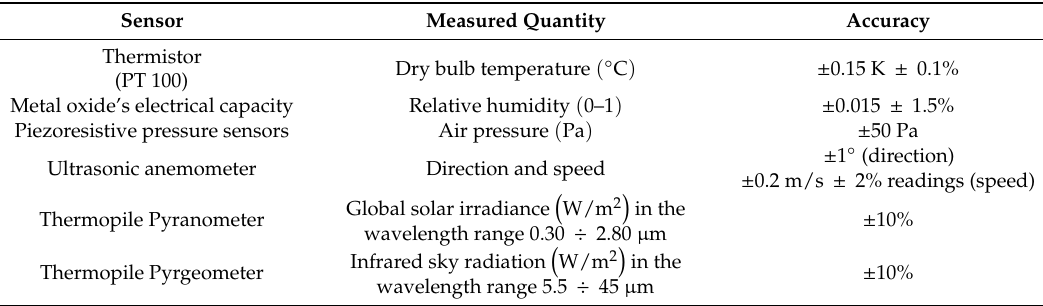
Table 2. Accuracy of the Weather Station